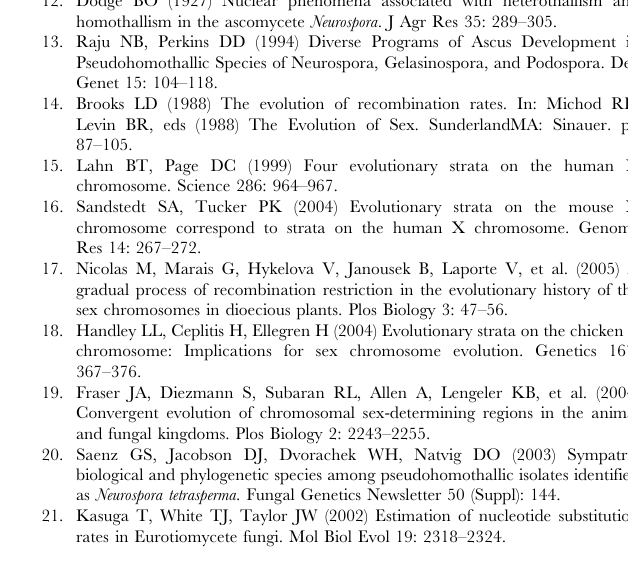
lineages of N. tetrasperma (Table 1), were PCR-amplified and sequenced using primers pairs upr-1F1 & upr-1R1, eth-1F1 & ethR1, lys-4F1 & lys-4R1, ad-9F & ad-9R and lys-3F1 & lys-3R1